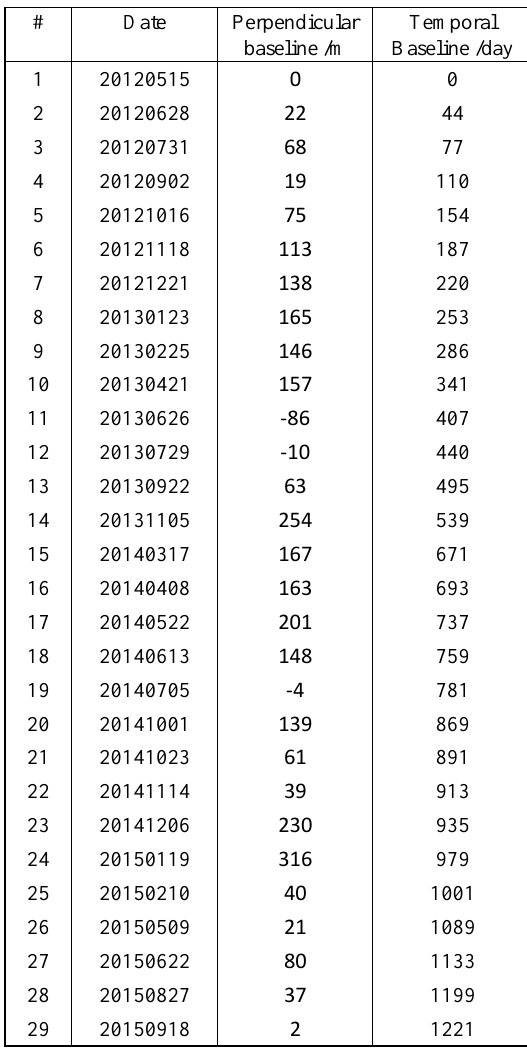
Table 1. List of the perpendicular and temporal baselines of